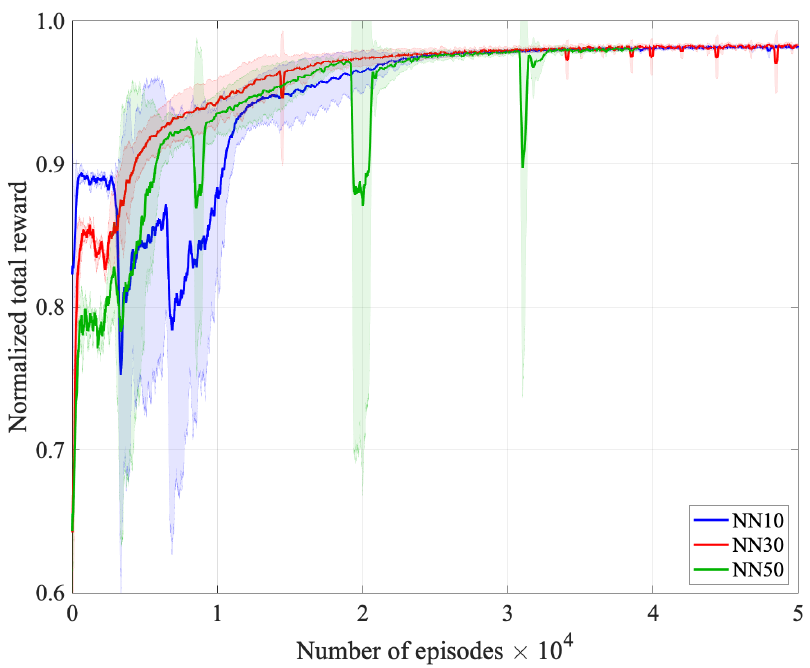
Figure 6. Training results. The solid lines are mean learning curves and the shaded areas are one standard deviation over 5 random